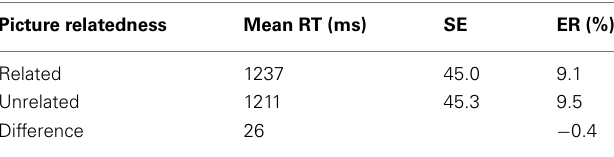
Table 1 | Mean response times, SE of means, and mean error rates for related and unrelated